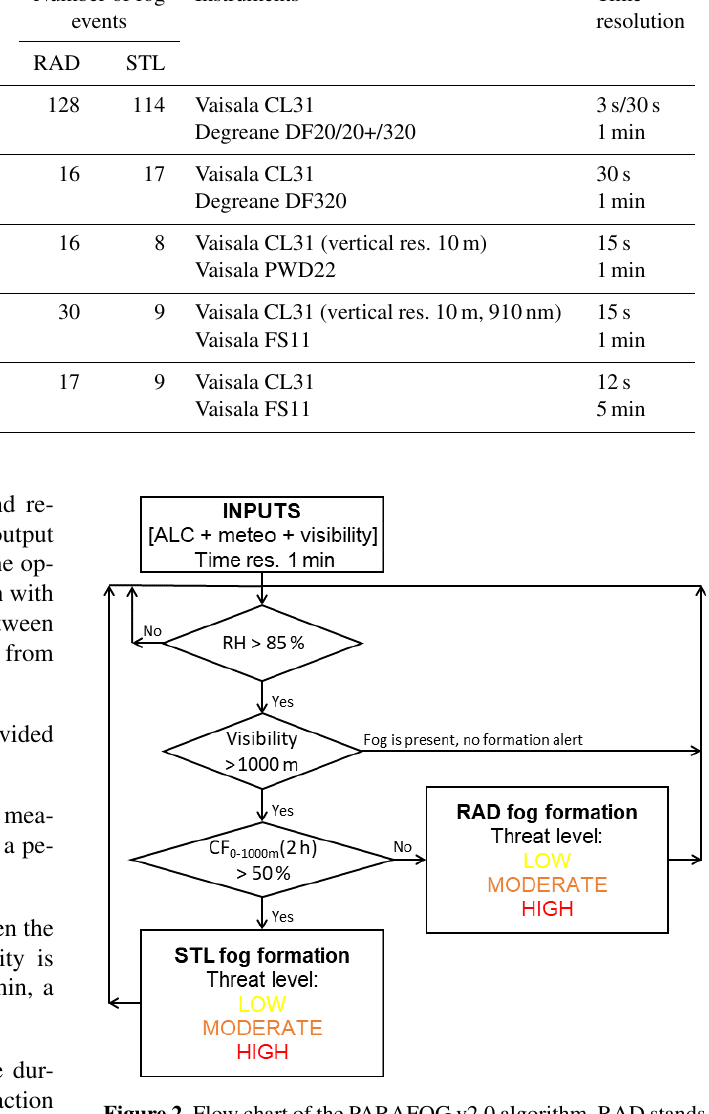
Figure 2. Flow chart of the PARAFOG v2.0 algorithm. RAD stands for radiation fogs, whereas STL refers to stratus lowering fog events. RH stands for relative humidity, and CF 0–1000m refers to the cloud fraction between 0 and